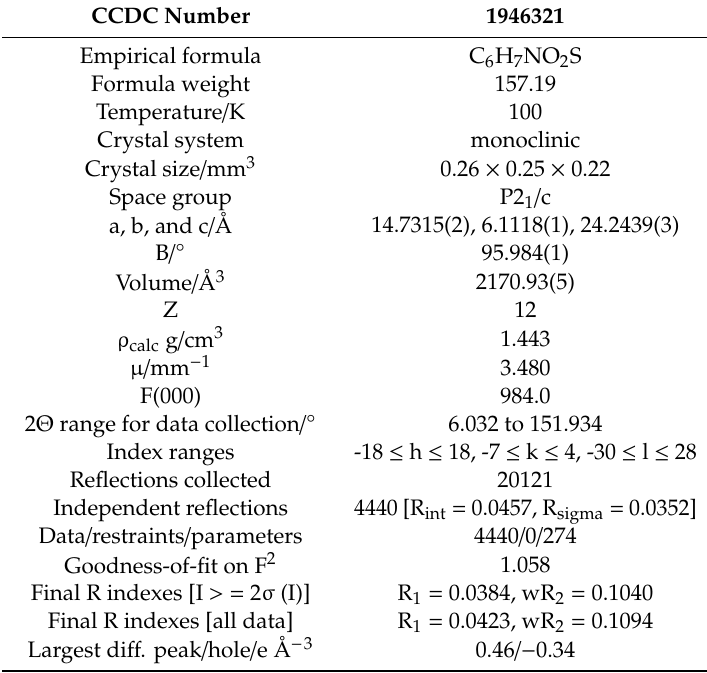
Table 1. Structure refinement parameters for